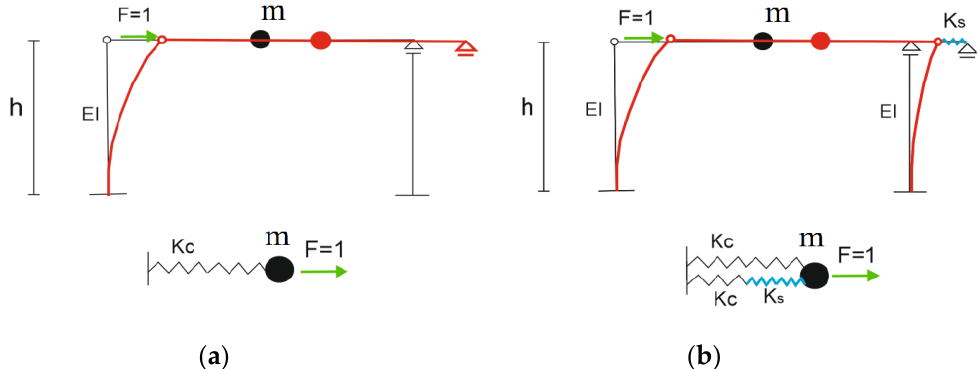
Figure 15. Simplified single degree of freedom transverse vibration frame models with equivalent mass–spring systems beneath: ( a ) the frictionless sliding on the right bearing, ( b ) the frictional sticking on the right